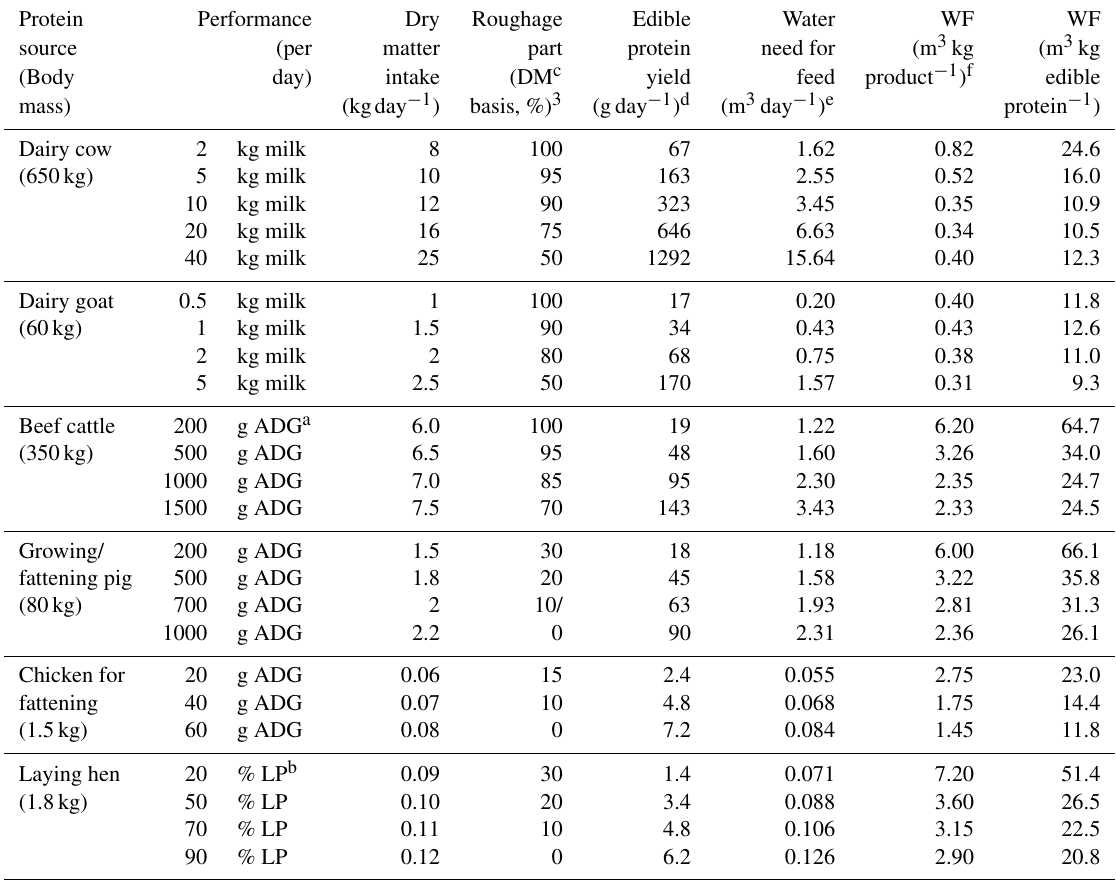
Table 13. Influence of animal species, categories and performances on yield of edible protein and water footprint (WF) per kilogram of edible protein. Protein